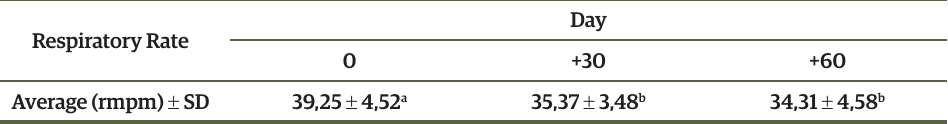
Table 2. Distribution of respiratory rate, in movements per minute, recorded during the physical evaluation of brachycephalic dogs, from January 2018 to December 2018, in the city of Seropédica, before (day 0) and after rhinoplasty procedure (days +30 and +60).